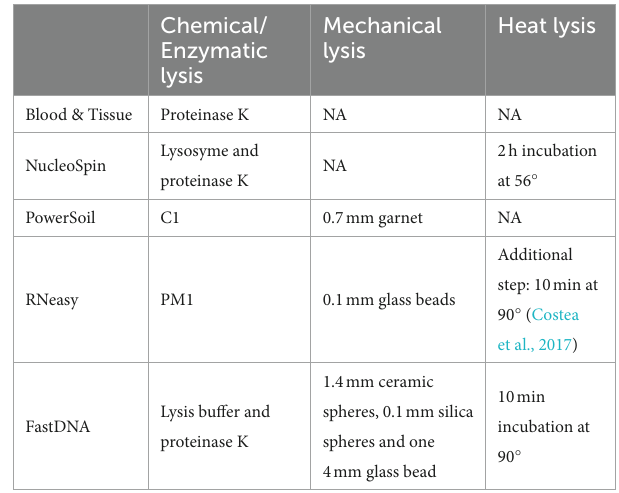
TABLE 2 Type of lysis per extraction